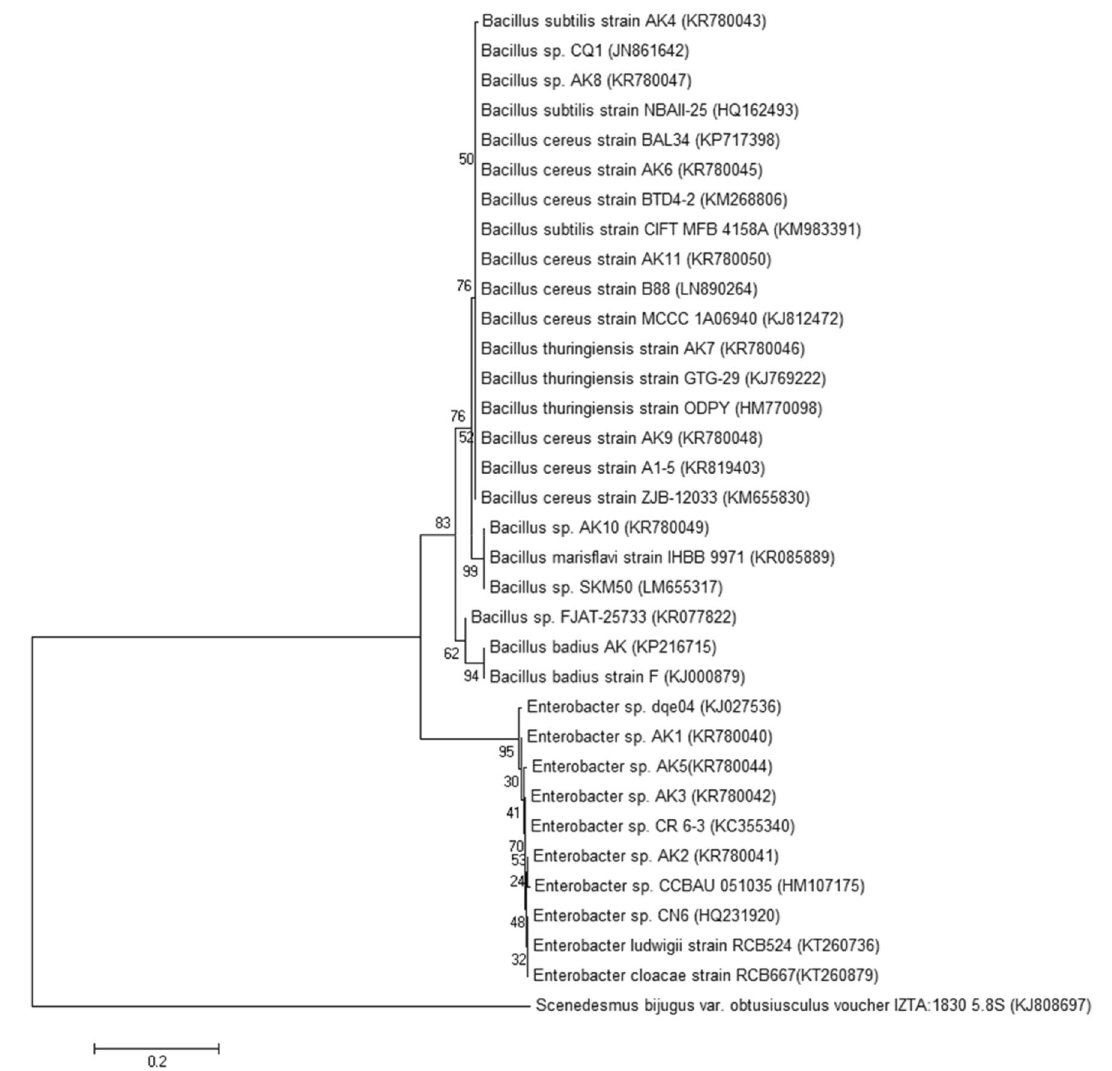
Fig. 5 Phylogenetic